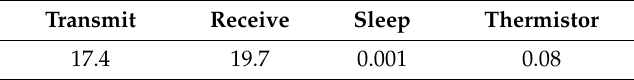
Table 6. Current consumption of system operations (in